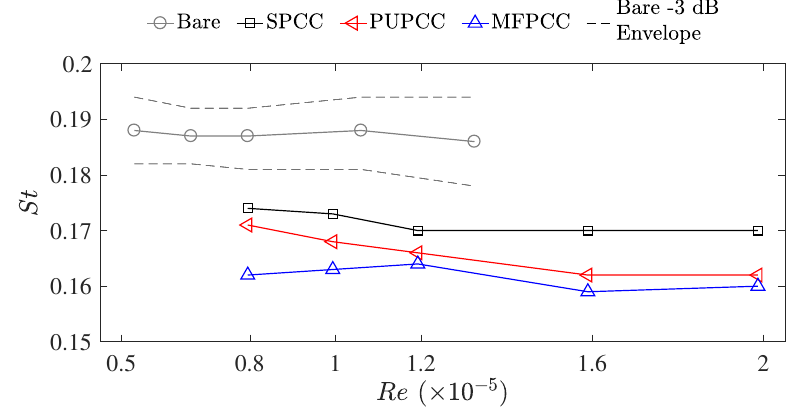
Figure 8. Strouhal numbers, St , of the bare cylinder shedding tone, f BARE , and the lower-frequency tone of the PCCs, f PCC . The dashed line represents the bare cylinder − 3 dB bandwidth window that very closely matches published data